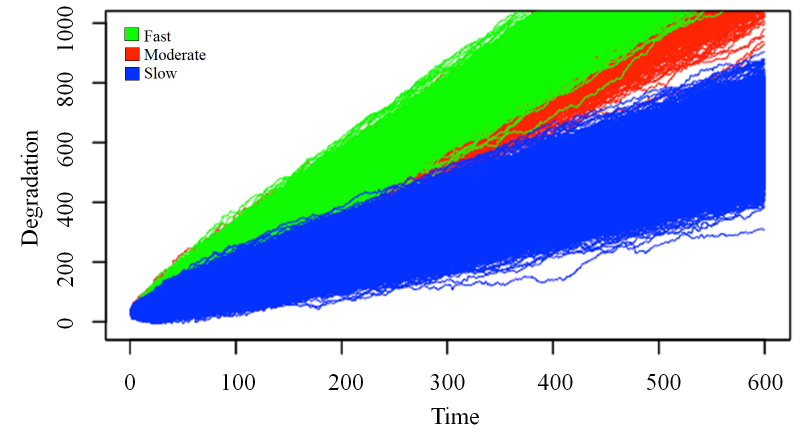
Figure 4. Degradation paths for different degradation state.